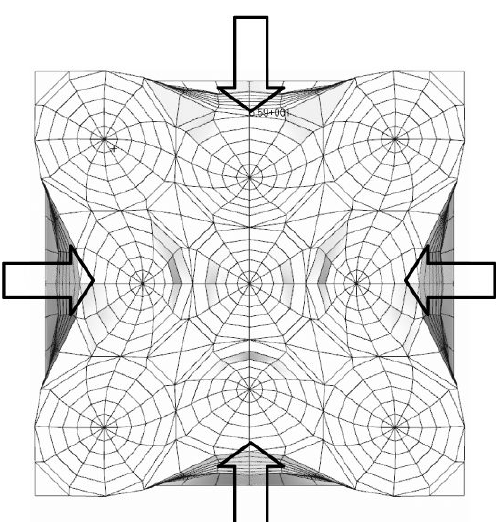
Fig. 34. 12th mode: 1535 Hz.